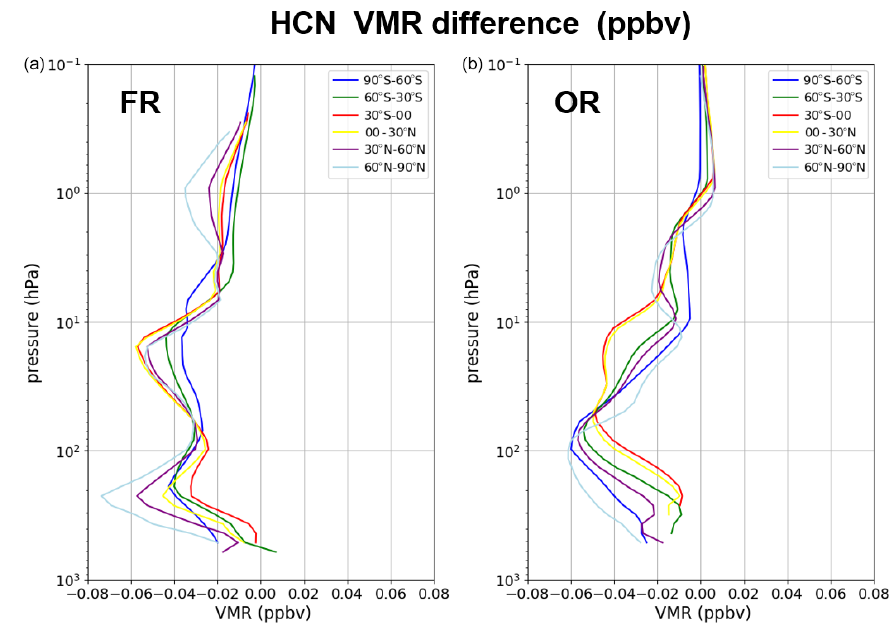
Figure 11. Same as Fig. 10, but for the HCN